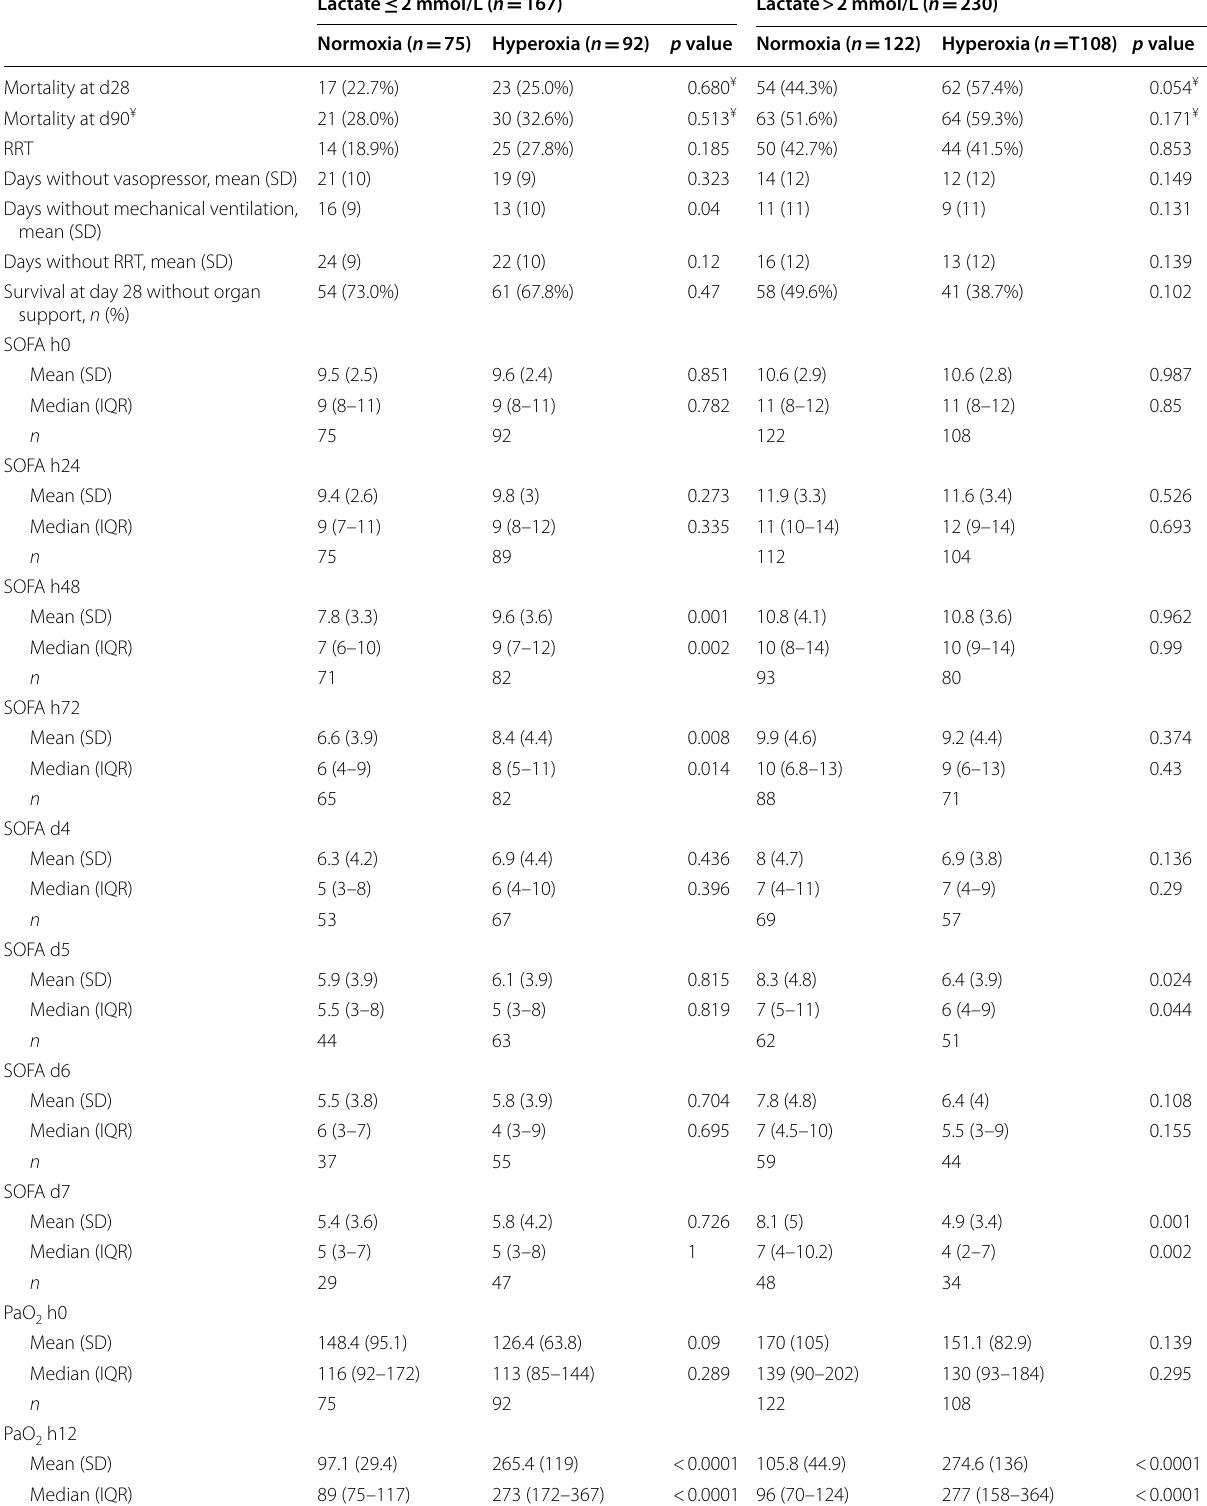
Table 2 Evolution of the clinical characteristics and illness severity scores of patients according to lactate level ( or > 2 mmol/L) and normoxia or hyperoxia